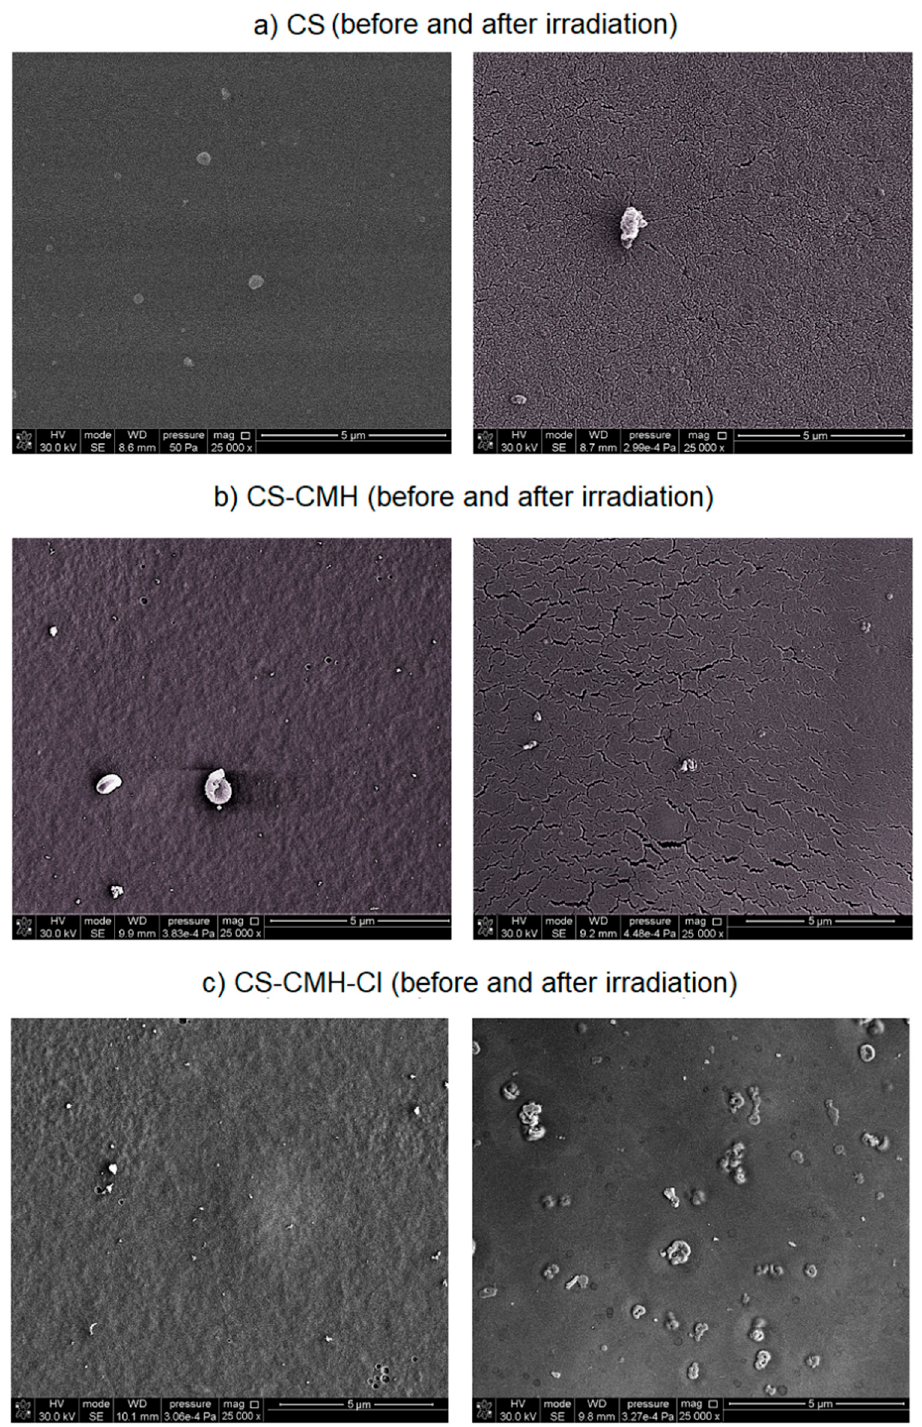
Figure 7. SEM images of ( a ) unmodified and ( b , c ) modified chitosan film surfaces before and after UV irradiation.